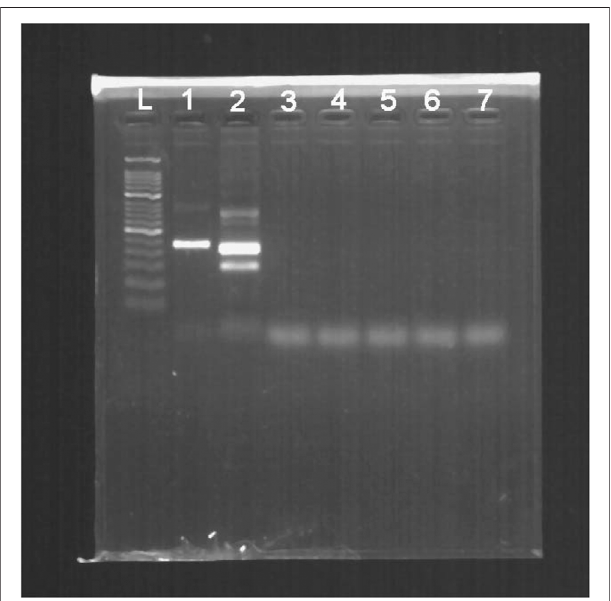
FIGURE 4 | The cross-reactivity test of multiple pathogens measured in 2% agarose gel electrophoresis. L, 50-bp DNA Ladder; 1, positive control ( ∼ 250 bp); 2, product of HBV; 3, product of HIV-1; 4, product of HSV-1; 5, product of JEV; 6, product of HAV; 7, product of HCV.